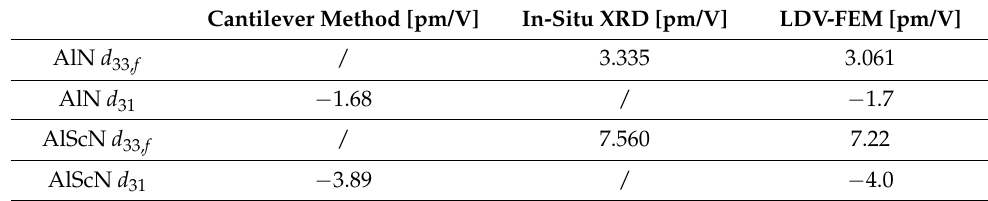
Table 5. Comparison of different test